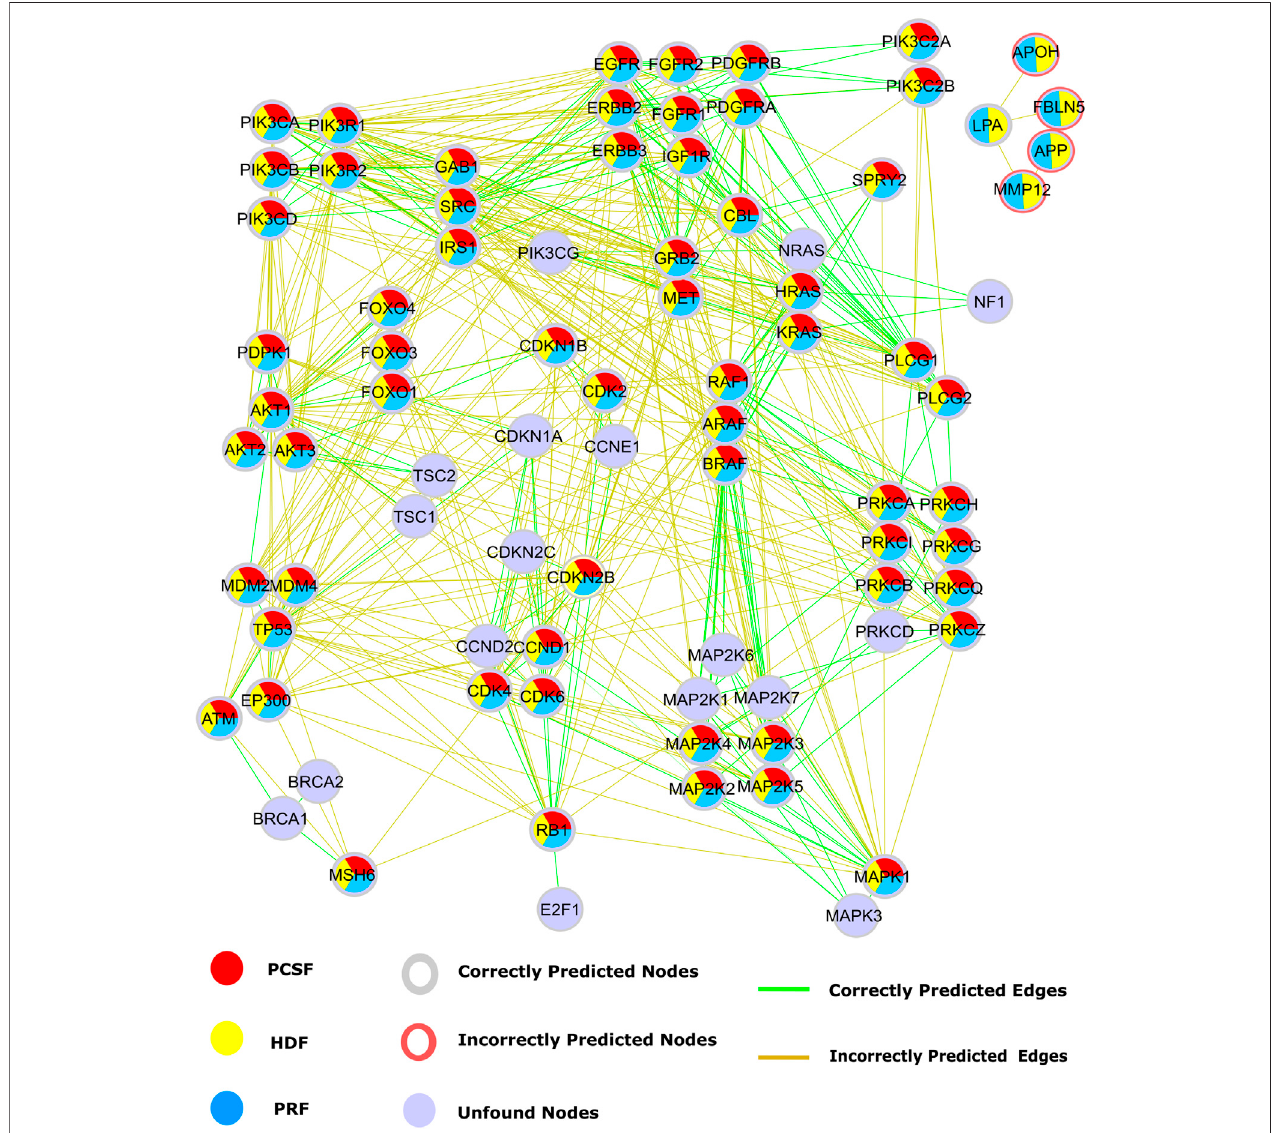
FIGURE 8 | Reconstructed signaling pathways in glioblastoma (WP2261) are predicted by PCSF are red, PRF are yellow, HDF are cyan, and nodes that are not found by any algorithm are colored light blue. Additionally, red rings represent the nodes that are incorrectly propagated. Green edges are the correct ones that are present in GBM pathway, while incorrect edges included by any algorithm are colored